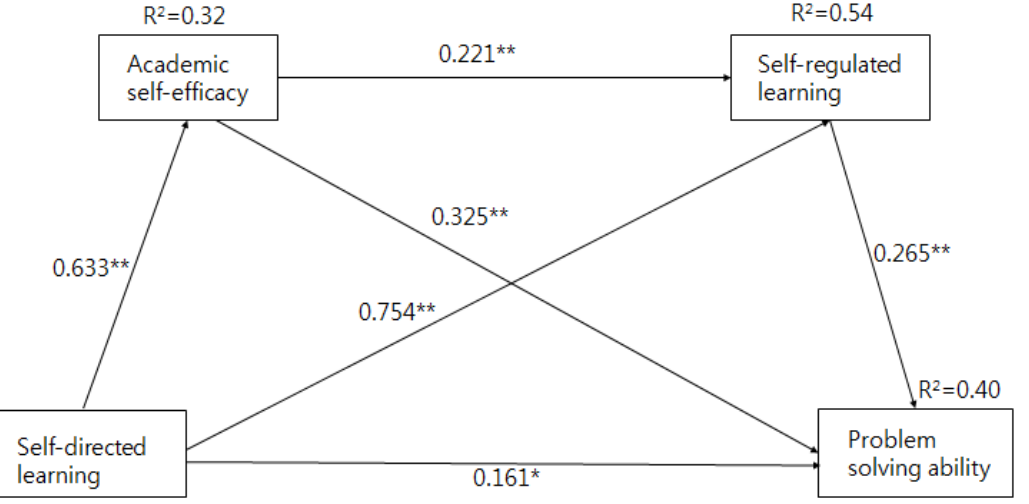
Figure 1. Results of the multiple mediation testing academic self-efficacy and self-regulated learning as mediators of the effect of self-directed learning on problem-solving ability. * p < 0.001. ** p < 0.05.